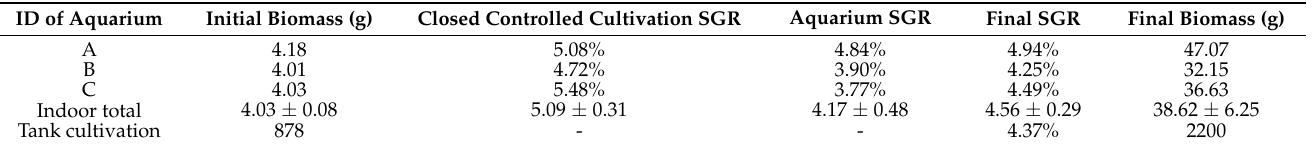
Table 1. Results of growth rate of Ulva sp. from Ulva sp. cultivated in indoor aquaria (A, B, and C) and cultivated in outdoor